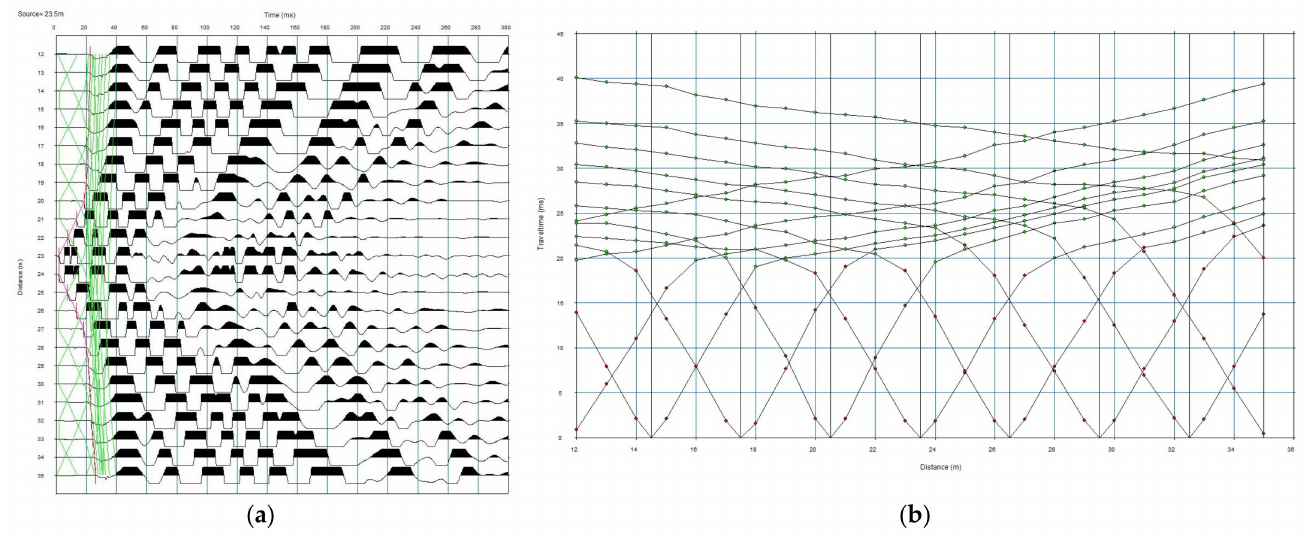
Figure 3. ( a ) First arrival picking with the shot point located in the middle of the seismic line, ( b ) P- wave travel time curves of the total 13 shot points along with the first (red dots) and second (green dots) layer